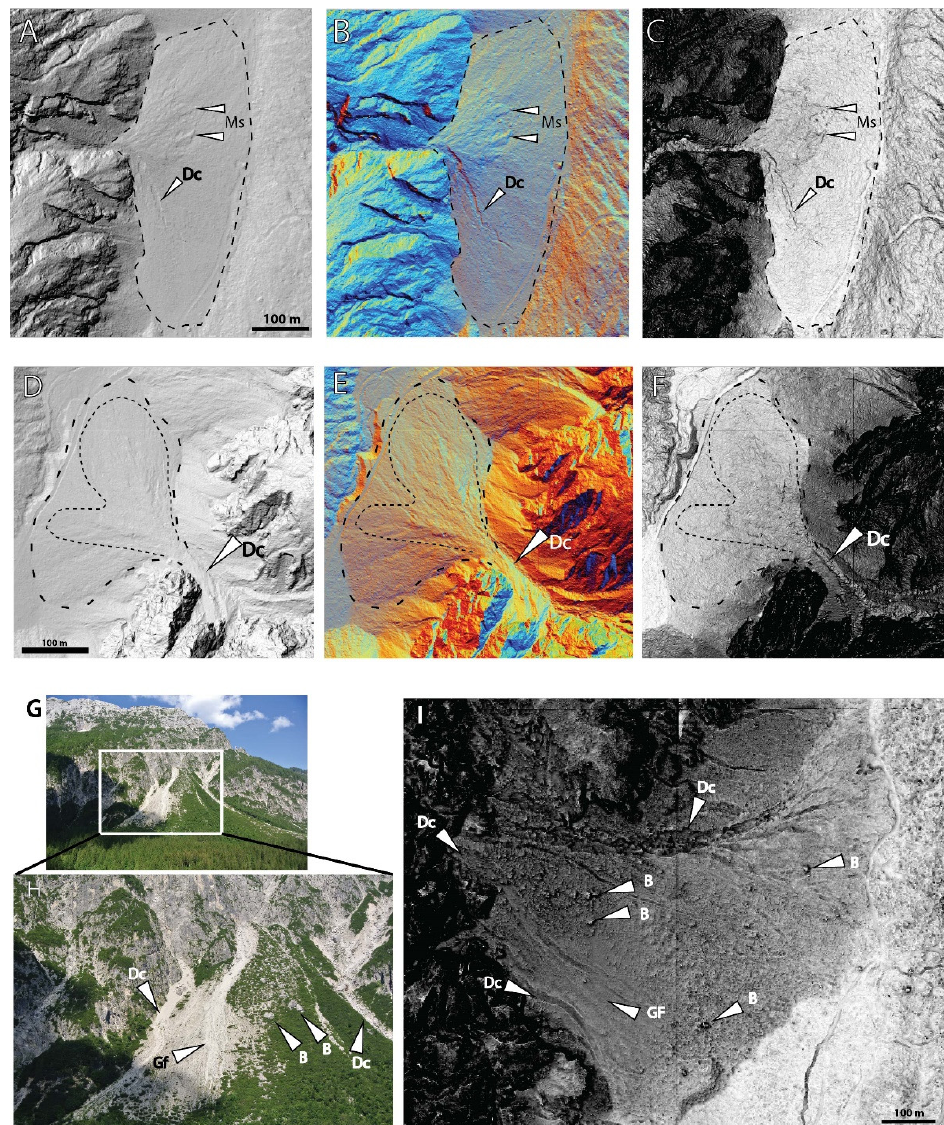
Figure 4. Visualisation of typical features on alluvial fans. For locations see rectangles 4 A-C, 4 D-F and 4 G-I in Figure 1. ( A – C ) Distributary torrential channels (Dc) and large sedimentary deposits, similar to sieve deposits and defined as “mega sieve deposits” (Ms, example in Figure 2 G) on alluvial fan represented on visualisations analytical hillshading (A315, H35), hillshading from multiple directions RGB (D16, H35) and 8-bit slope respectively. ( D – F ) Area of out-of-channel deposits and corresponding distributary channel (Dc) on an alluvial fan marked with thin dashed line represented on visualisations analytical hillshading (A315, H35), hillshading from multiple directions RGB (D16, H35) and Slope (8-bit) respectively. ( G , H ) Example of Type 1 alluvial fan with boulders (B), grain flow areas (Gf) and distributary channels (Dc). ( I ) Same alluvial fan represented on 8-bit Slope visualisation. Notice boulders (B), grain flow areas (Gf) and distributary channels (Dc) marked with white arrows.